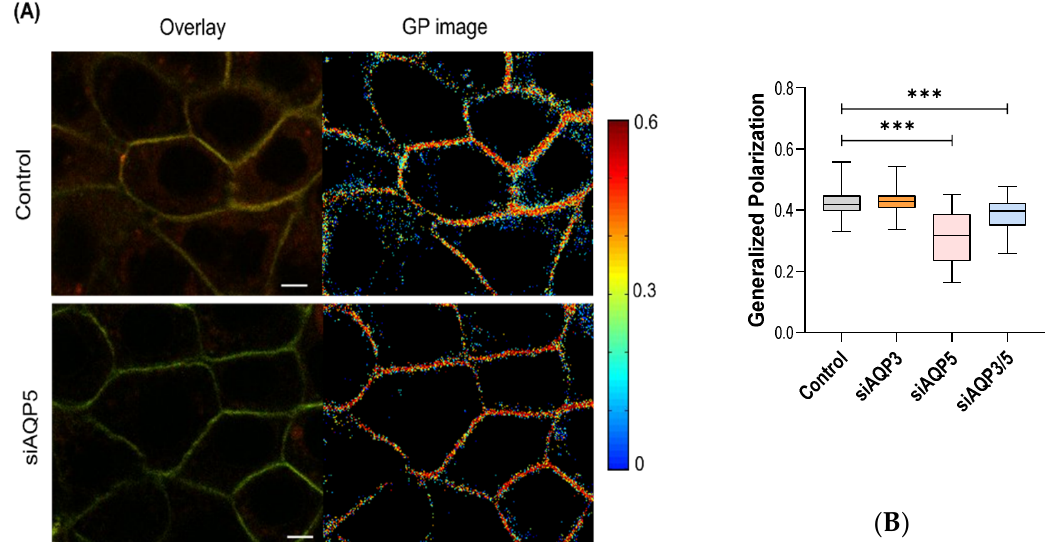
Figure 3. ( A ) Two-photon fluorescence microscopy of BxPC-3 cells labeled with Laurdan. Images from the left panel correspond to the overlay of equatorial z-section images taken with emission set at 400–460 nm (green channel) and 470–530 nm (red channel). GP images (right) were obtained by applying the GP function to the images from green and red channels, pixel by pixel. Scale bars: 5 μm. ( B ) GP values after incubation with Laurdan averaged from at least 50 different cells in each experimental condition for each one of the 3 independent experiments. *** p < 0.001, silenced vs. control cells.